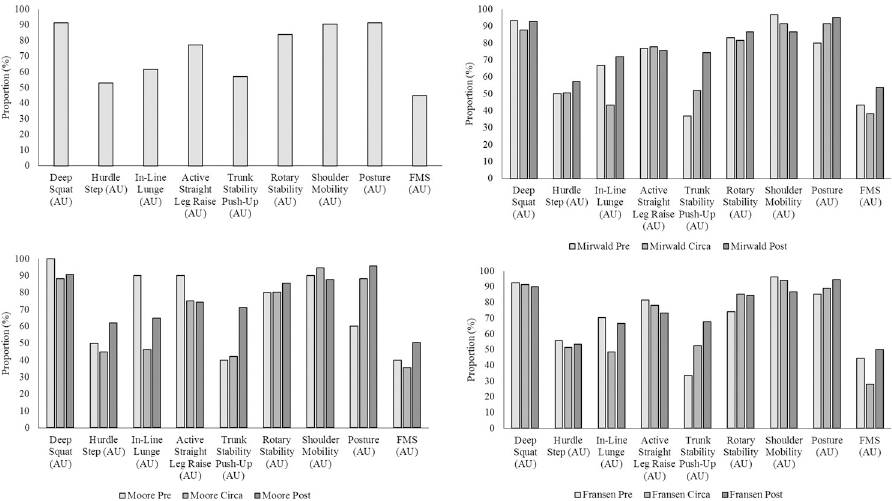
Fig 2. Comparison of proportion of players within each grouping (a—chronological or maturity status; b–Mirwald, Baxter-Jones. [23] c–Moore, McKay. [29]; d–Fransen, Bush [24]) bio-banding ‘pre = PHV’ (pre), ‘circa-PHV’ (circa) and ‘post-PHV’ (post)) achieving the threshold value of � 2 ( � 14 for composite FMS) for all measures of functional movement and postural assessment.